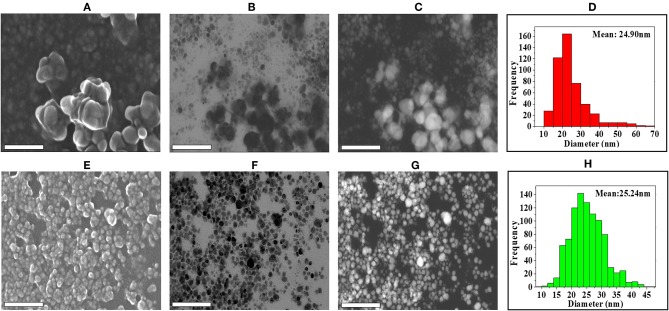
Analysis of the shape, morphology, and size of biogenic Ag nanoparticles (bAgNPs) with scanning transmission electron microscope (STEM). SE images show the formation of Aq-bAgNPs (A). Scanning TEM images (B), high-angle annular dark-field (HAADF) images (Z-contrast images) (C), and histogram for particle size distribution (D) show the formation, spherical shape, and size of Aq-bAgNPs. Similarly, SE (E), scanning TEM (F), HAADF images (G), and histogram for particle size distribution (H) show the formation spherical shape and size of Et-bAgNPs. Scale bar: 200 nm.